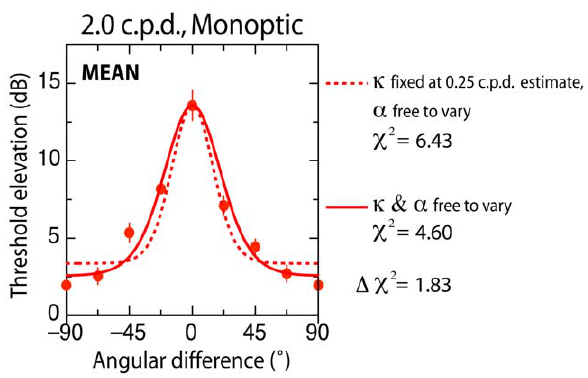
Figure 4. Comparison of circular variance ( k ) as a function of spatial frequency. Data represent threshold elevation averaged across subjects in the 2 c.p.d. monoptic condition. In one case, Equation 2 is fit with two free parameters ( k and a ; solid curve) while in the other it is fit with only one free parameter ( a ), with k was fixed at the value found in the 0.25 c.p.d. monoptic condition (dashed curve). The difference between these fits fails to exceed the critical value of 3.84 (p . .05; 1 degree of freedom), indicating no significant difference in bandwidths (circular variance) across spatial frequency.